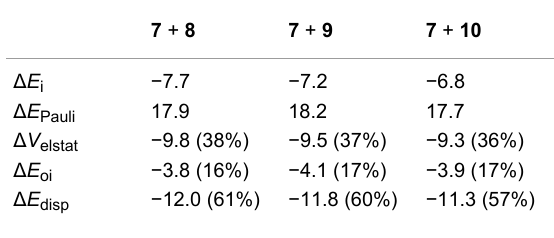
Table 1: Energy decomposition analysis (EDA) of the three com- plexes shown in Scheme